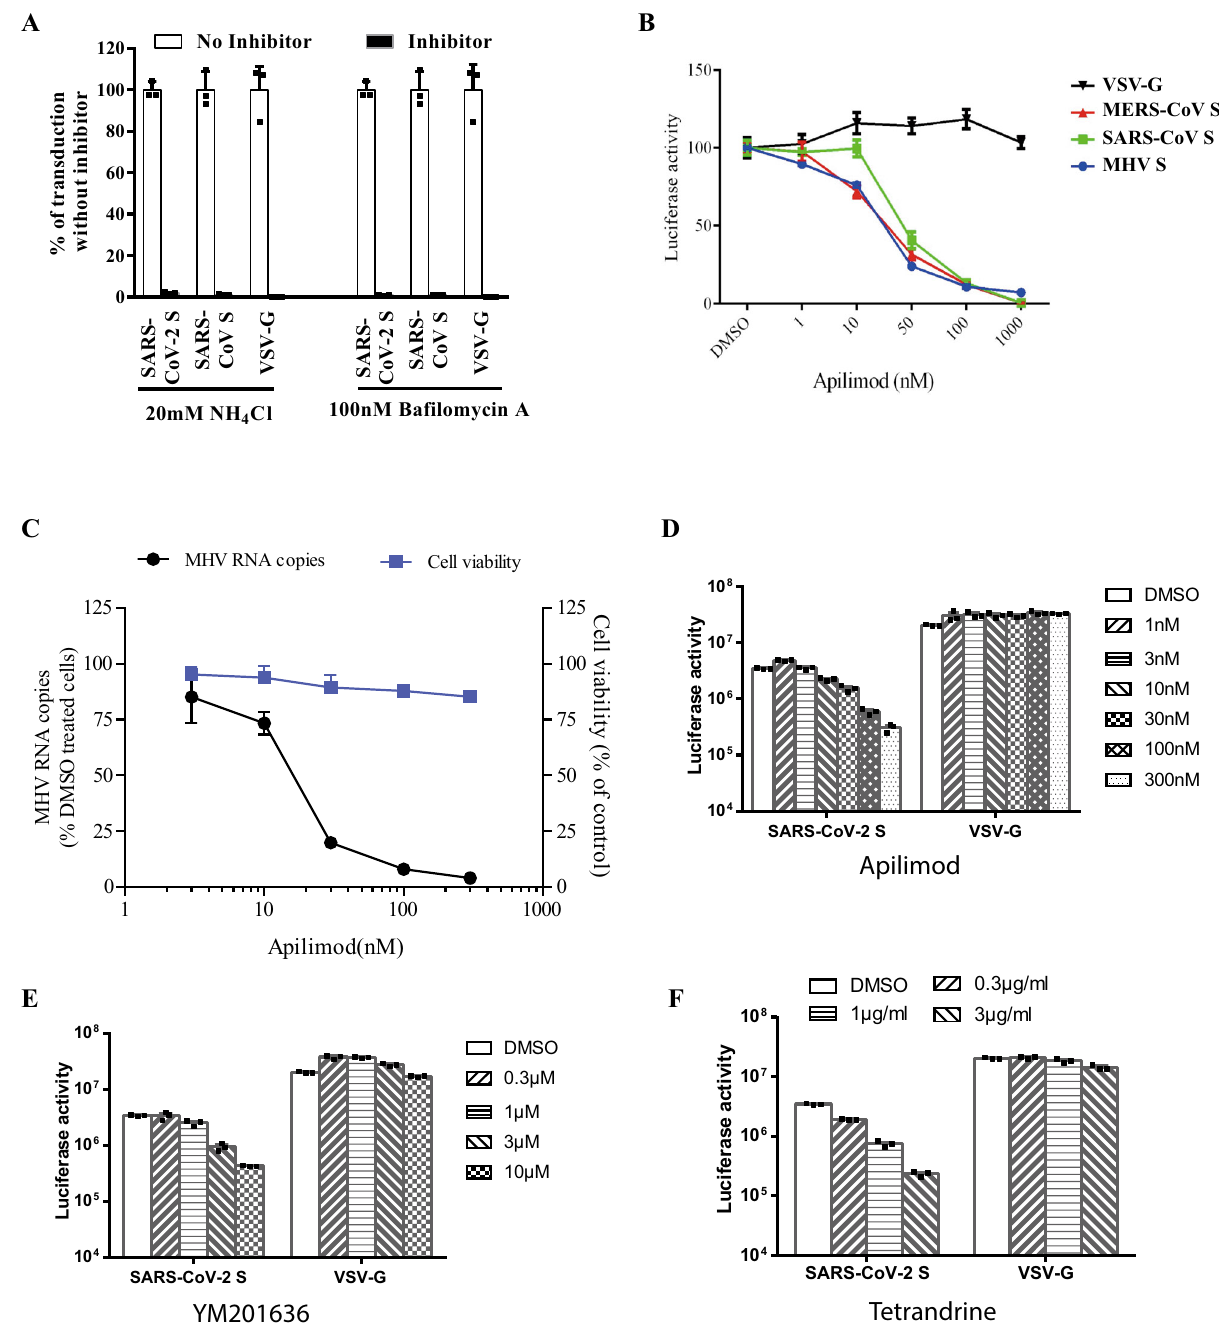
Fig. 3 Endocytosis of SARS-CoV-2 S pseudovirions on 293/hACE2 cells. a Inhibition of entry of SARS-CoV-2 S pseudovirion on 293/hACE2 by lysosomotropic agents (20 mM NH 4 Cl and 100 nM ba fi lomycin A). b Inhibition of entry of SARS-CoV, MERS-CoV, and MHV S pseudovirions by a PIKfyve inhibitor apilimod. HeLa/mCEACAM, 293/hACE2, HeLa/hDPP4 cells were pretreated with different concentrations of apilimod and transduced with MHV S, SARS-CoV S, MERS-CoV S pseudovirions, respectively. The luciferase activity was measured 40 h post transduction. VSV-G pseudovirions were used as a control. Experiments were done in triplicates and repeated at least three times. One representative is shown with error bars indicating SEM. c Inhibition of MHV A59 infection by apilimod. The 17Cl.1 cells were pretreated with 3, 10, 30, 100, 300 nM apilimod for 30 min and infected by MHV A59 at MOI = 0.01. Viral infection and cell viability were determined by using qPCR and MTT assay, respectively. Experiments were done in triplicates and repeated at least three times. One representative is shown with error bars indicating SEM. d , e Inhibition of entry of SARS-CoV-2 S protein pseudovirions by apilimod, YM201636, and tetrandrine. HEK 293/hACE2 cells were pretreated with either apilimod ( d ), YM201636 ( e ), or tetrandrine ( f ), then inoculated with SARS- CoV-2 S pseudovirons in the presence of drug. The luciferase activity were measured 40 h post transduction. YM201636, PIKfyve inhibitor; tetrandrine, TPC2 inhibitor. The experiments were done in triplicates and repeated at least three times. One representative is shown with error bars indicating SEM of technical triplicates. Source data are provided as a Source Data fi